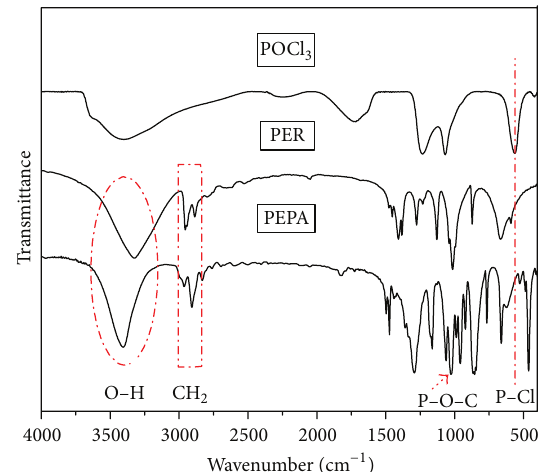
Figure 1: FTIR spectra of POCl 3 , PER, and PEPA.